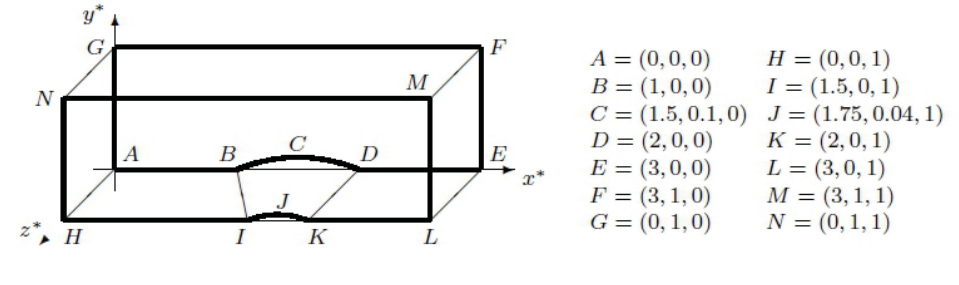
Figure 2: test case S WEPT W